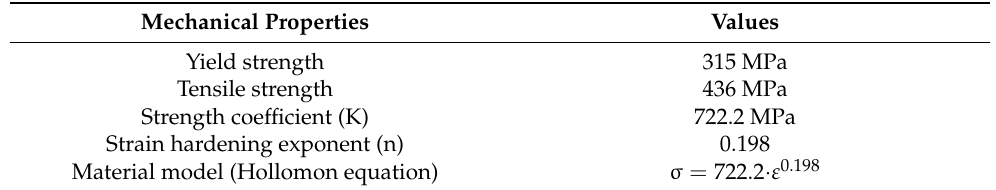
Table 1. Mechanical properties for SAPH440.